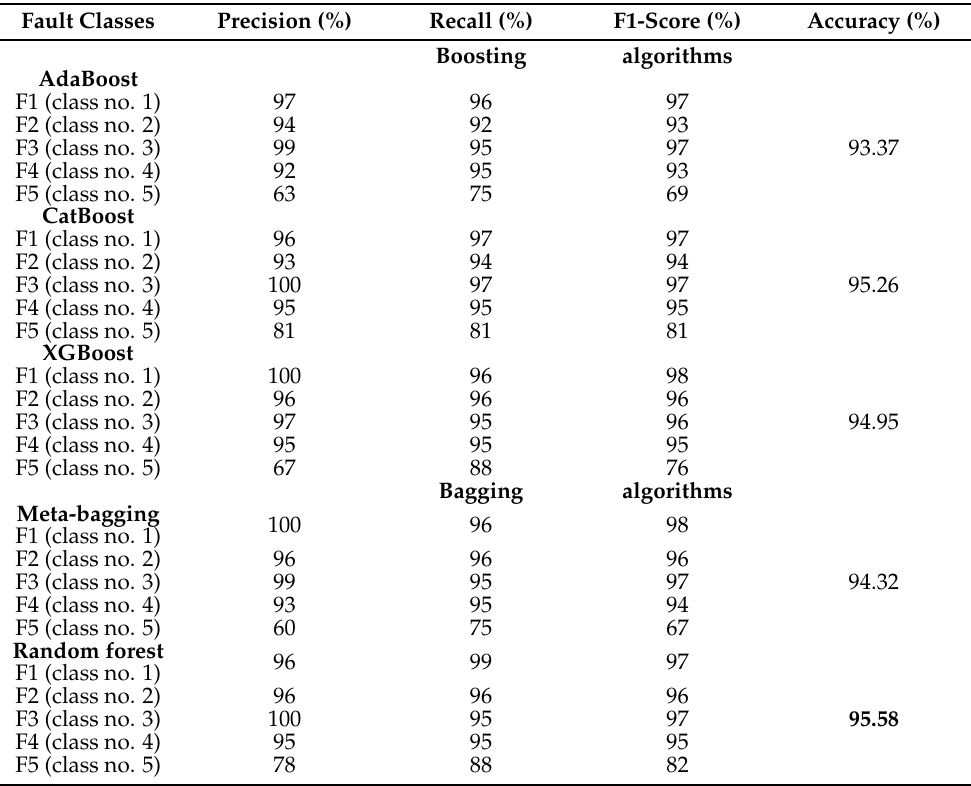
Table 5. Accuracies of various classification